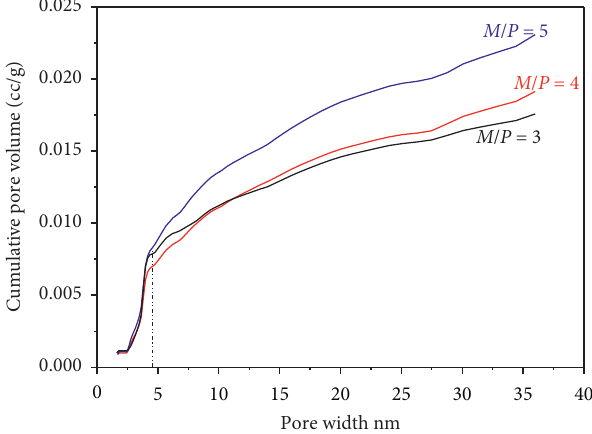
Figure 15: Cumulative pore volume curves of MPC with the M / P ratios of 3:1, 4 :1, and 5:1 cured under air-curing conditions for